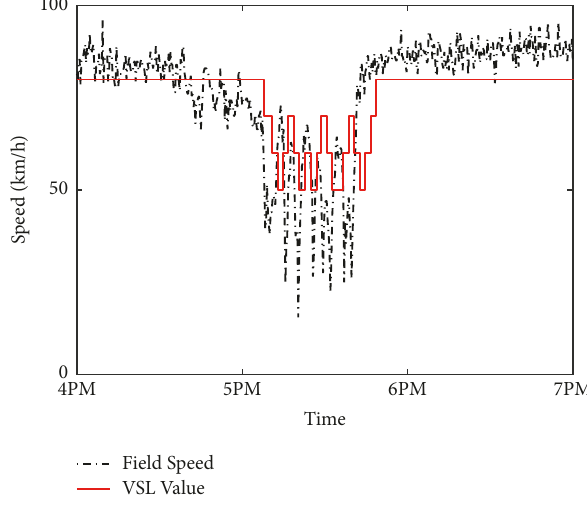
Figure 5: Speed profile of case study day Aug.17, 2015.